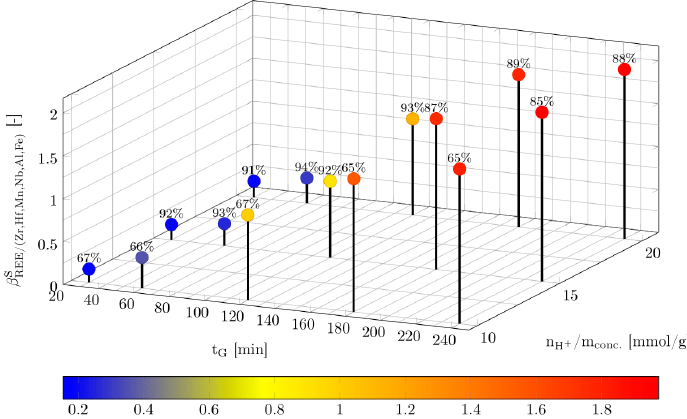
Figure 5. Effect of acid addition and roasting time on separation factor (y-axis, colored bar) and leaching yields of REEs in percent ( T G = 750 °C; ϱ PD,L = 25 kg/m 3 ; T L = 20 °C; t L = 24 h; r R,L = 300 rpm).